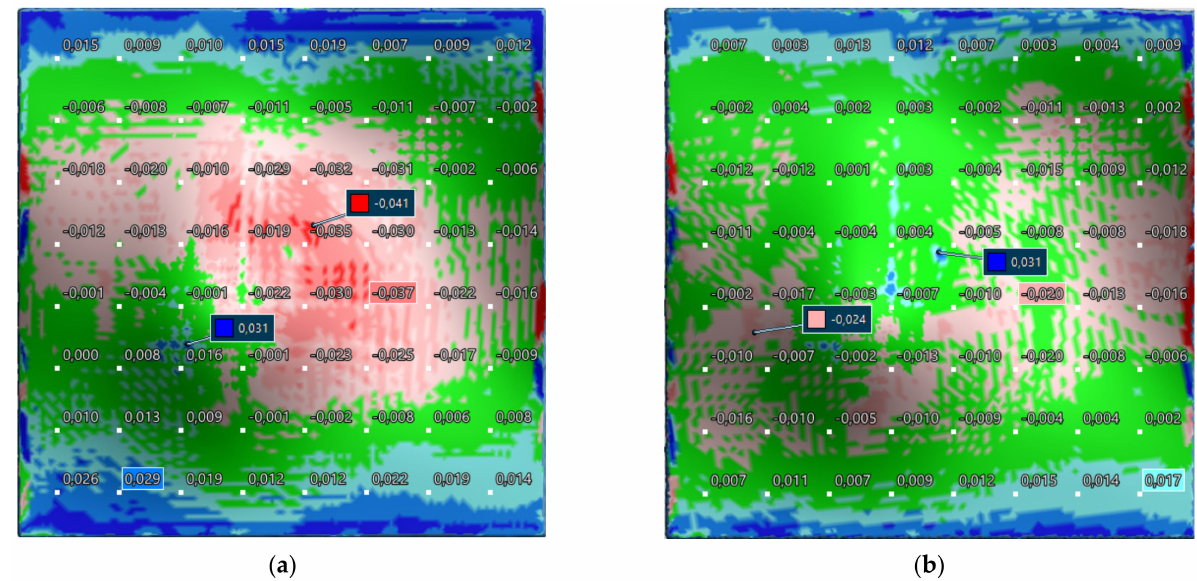
Figure 5. Deviation values for scanned sample surfaces made using the spiral strategy: ( a ) 3- and ( b ) 5-axis converted